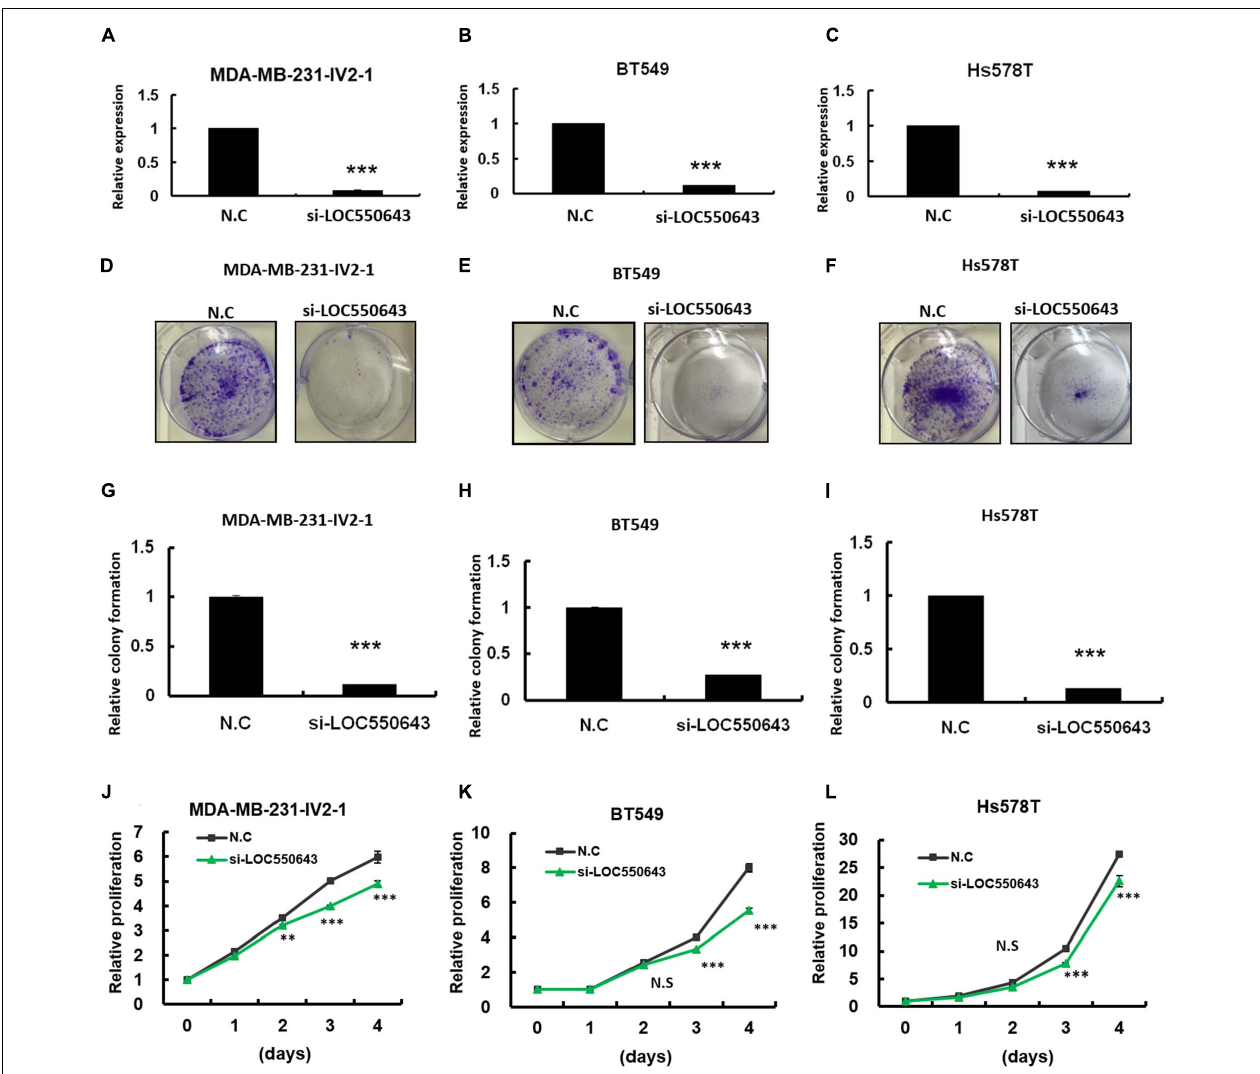
FIGURE 4 | Examination of LOC550643 cellular function in breast cancer cell lines. The siRNAs (N.C, si- LOC550643 -pool) were individually transfected into breast cancer cells (MDA-MB-231-IV2-1, BT549, and Hs578T) followed by cellular function examination. (A–C) Relative expression of LOC550643 in three breast cancer cell lines after siRNA transfection (real-time PCR). (D–F) Colony formation assay performed for MDA-MB-231-IV2-1, BT549, and Hs578T cells after transfection with si- LOC550643 or a scramble control. The cells were fixed and stained with crystal violet solution. (G–I) Relative colony formation ability quantified using a 595-nm optical density. (J–L) Cell proliferation measured using the CellTiter-Glo assay at various time points following LOC5506431 knockdown (0, 1, 3, and 4 days) as compared with the scramble control. All experiments were carried out in triplicate. Using Student’s t -test to analyze our data and p < 0.05 was considered significant (* p < 0.05, ** p < 0.01, and *** p <